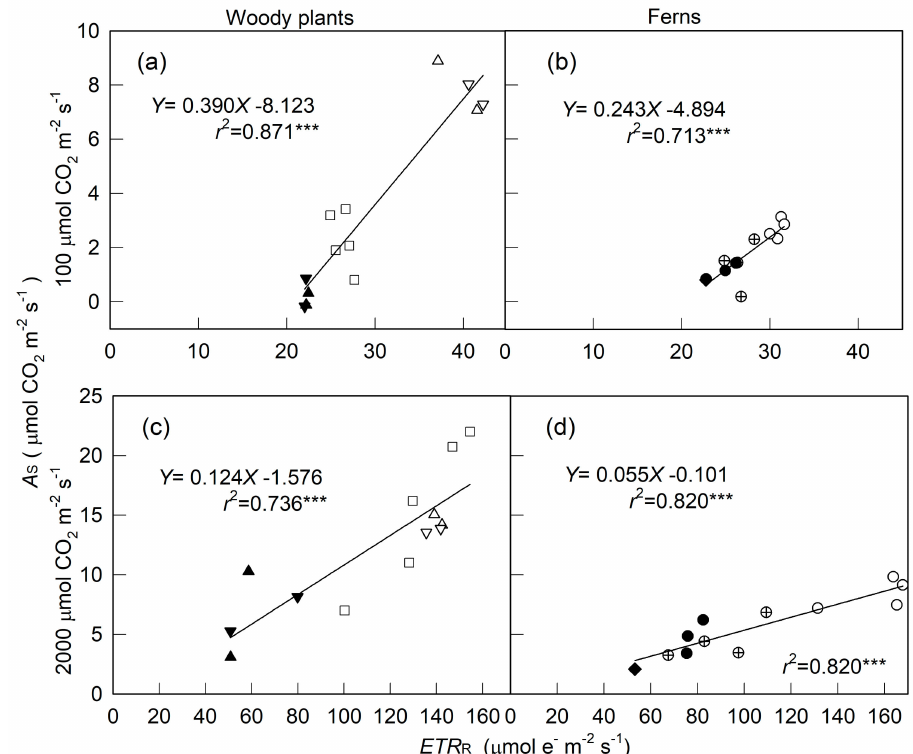
Figure 4. Relationship between net photosynthetic rate from steady-state light response ( A S ) and electron transport rates from a rapid light response ( ETR R ) for all tested materials at 100 ( a , b ) and 2000 ( c , d ) µ mol m − 2 s − 1 PPFD. (cid:3) is Alnus formosana ; (cid:52) is Salix Warburgii ; (cid:53) is Ficus microcarpa ; (cid:78) is Ardisia crenata ; (cid:72) is Ardisia cornudentata ; # is Pyrrosia lingus ; ⊕ is Asplenium antiquum ; • is Diplazium donianum ; (cid:117) is Archangiopteris somai . A S for ferns and understory shrubs measured at 75% relative humidity were from [3]. *** is significant at p <